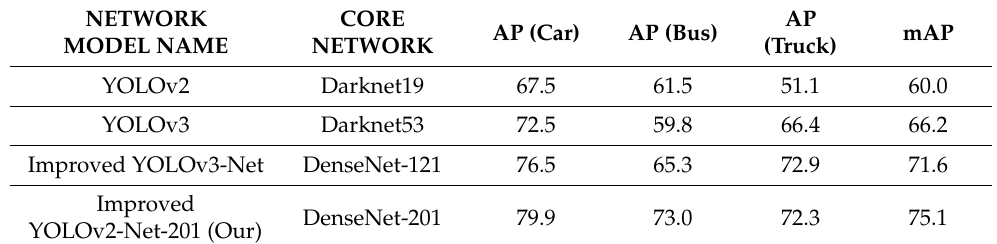
Table 7. Comparison of Proposed Network with existing models on the COCO dataset. NETWORK